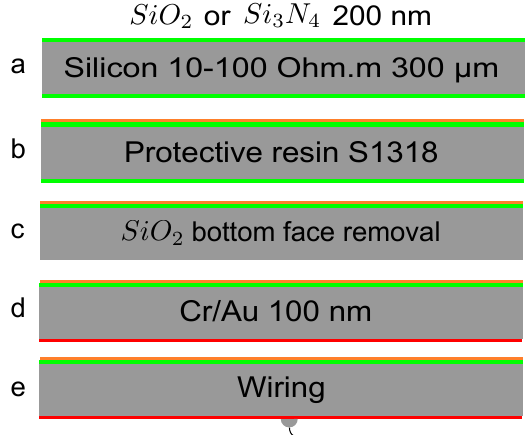
Figure 8. Flow chart of the clean room process used to fabricate the